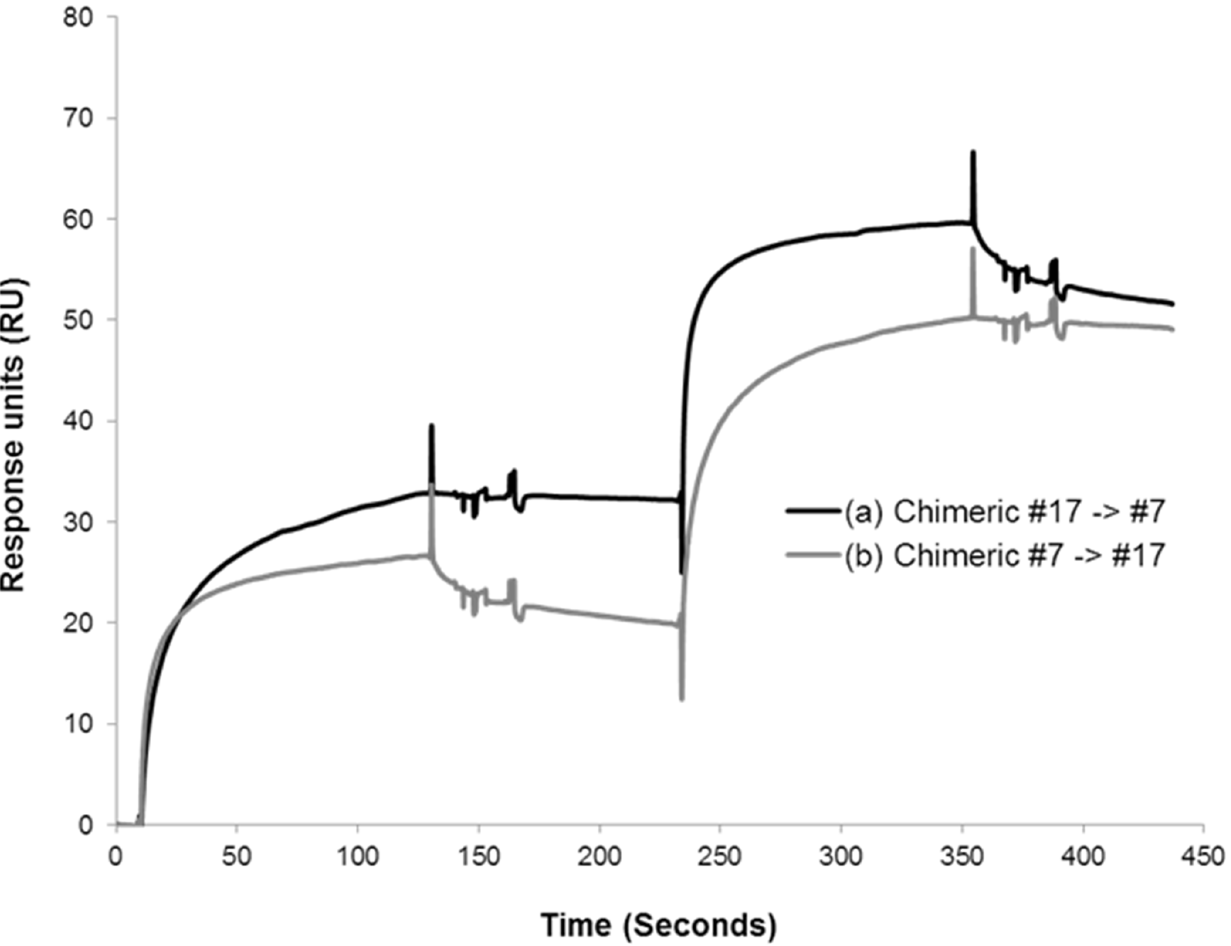
Fig 2. Epitope mapping study by SPR assay. SPR experiments were performed by injectingchimeric MAbs #7 and #17 (1 μ M). The time in seconds (x-axis) is plotted againstthe RU (y-axis). RU levels are indicatedfor each injectedantibody.(a) Injectionorder: chimeric MAb #17 - > #7. (b) Injectionorder: chimeric MAb#7 - > #17.